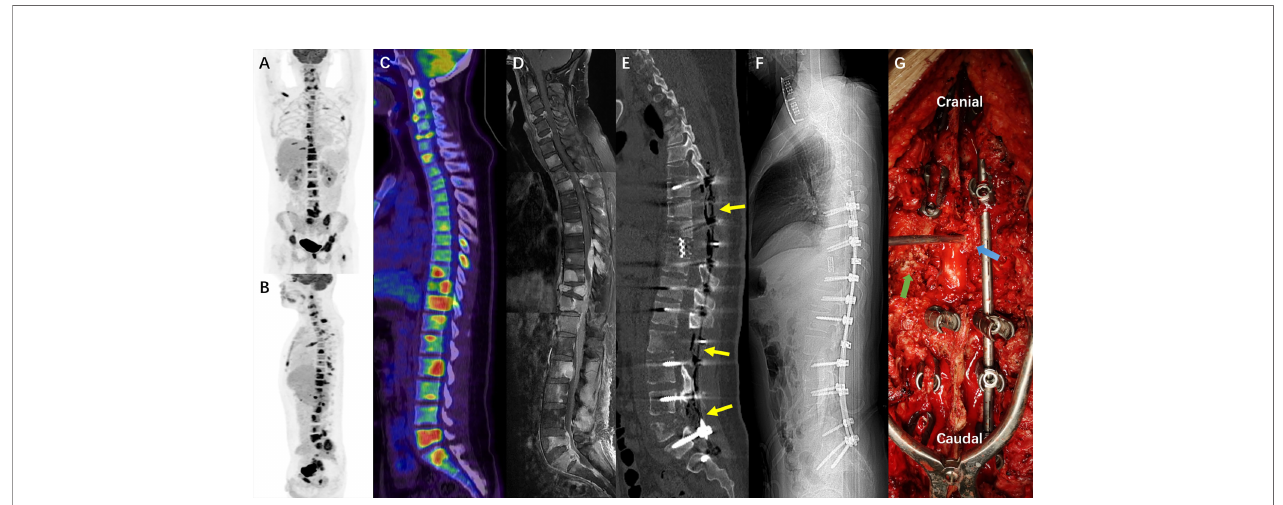
FIGURE 5 | (A – C) The PET/CT images (22 nd Dec. 2020) showed extensive osseous metastases including multilevel vertebrae, right clavicle, left 4 th rib, pelvis, and the great trochanter of left femur. (D) The mosaic image of cervical, thoracic and lumbar MRI with contrast, showing extensive axial skeletal metastases corresponding to the PET/CT, and intraspinal drop metastases compressing the spinal cord. (E, F) , the sagittal reconstruction and scout scan of postoperative all spine CT demonstrated the multilevel laminectomy (T7-9, L2-3, and L5-S1) and T10 total spondylectomy with titanium mesh reconstruction (18 th Jan. 2021). (G) , the intraoperative picture during T10 spondylectomy showed metastatic tumor tissues in the paraspinal muscles (green arrow) and the epidural space of the thoracic canal (blue